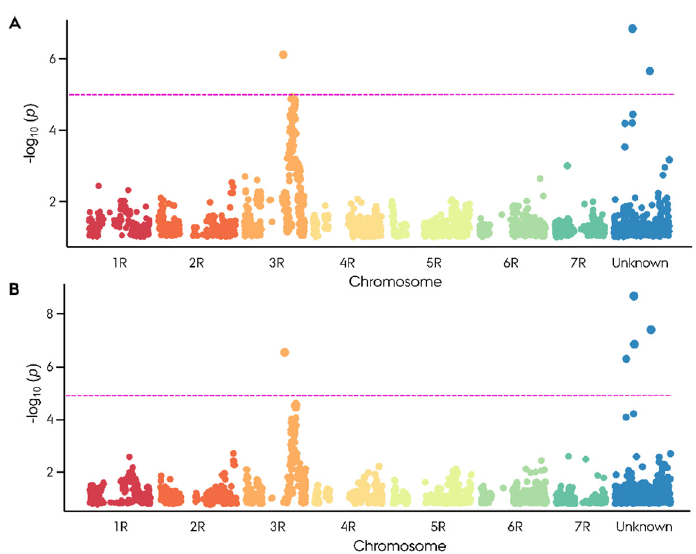
Figure 3. Manhattan plot for genome-wide association study on the restoration of male-fertility- related phenotypic scores. ( A ) Seed number and ( B ) pollen production (1–9) in an F 2 biparental population composed of 181 plants derived from the hybrid rye cv. Stannos. In total, 3494 informative SNP markers were used. Significant association was identified using criterion of − log 10 ( p ) > 4.85 depicted as a magenta line.